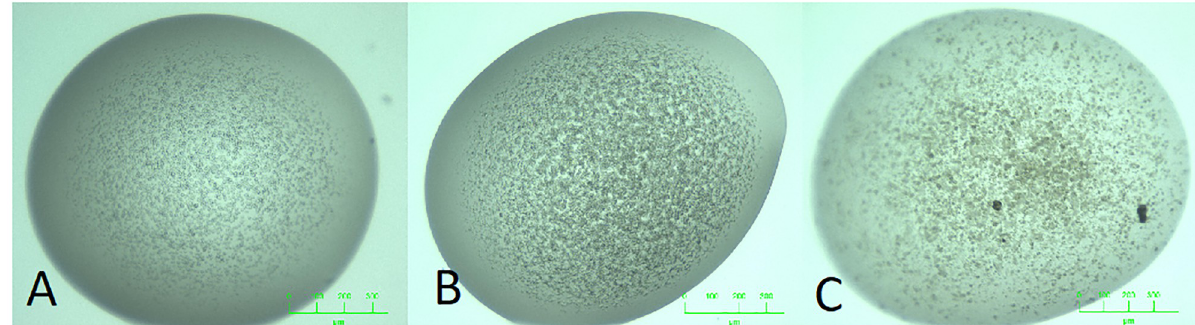
Fig 1. Blurred boundaries between MARCO classes. The three images here look similar, but have been classifed into three different MARCO classes by a crystallographer A: Other (phase separation). B: Precipitate. C. Crystal.